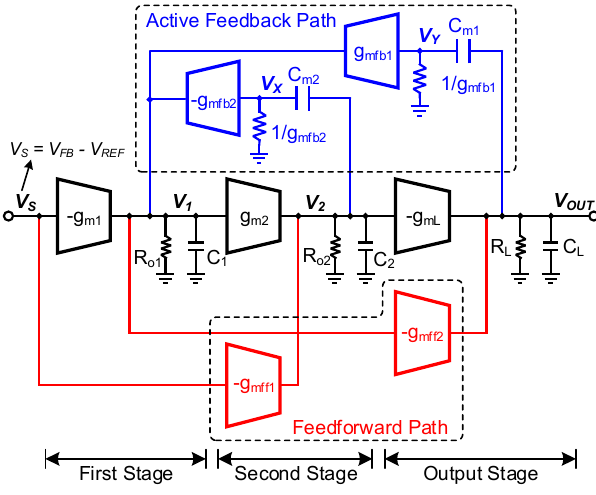
Figure 4. Three stage amplifier with the proposed AFCFC.